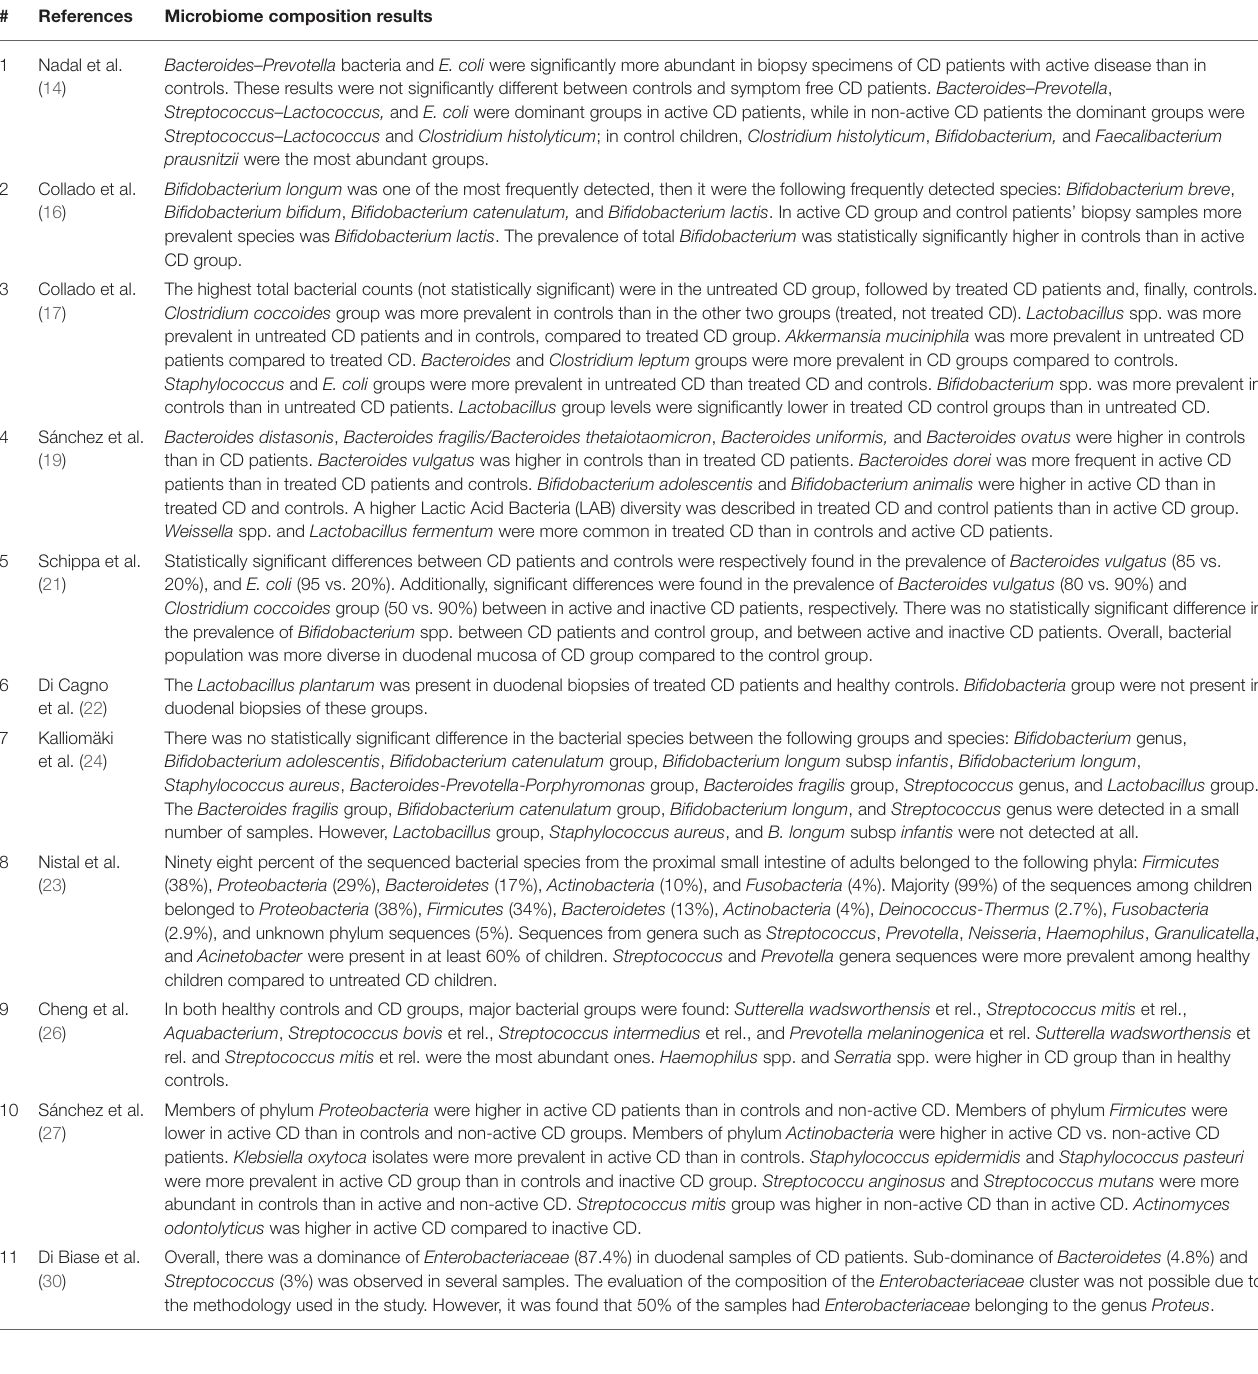
TABLE 3 | Main findings from the studies investigating the duodenal